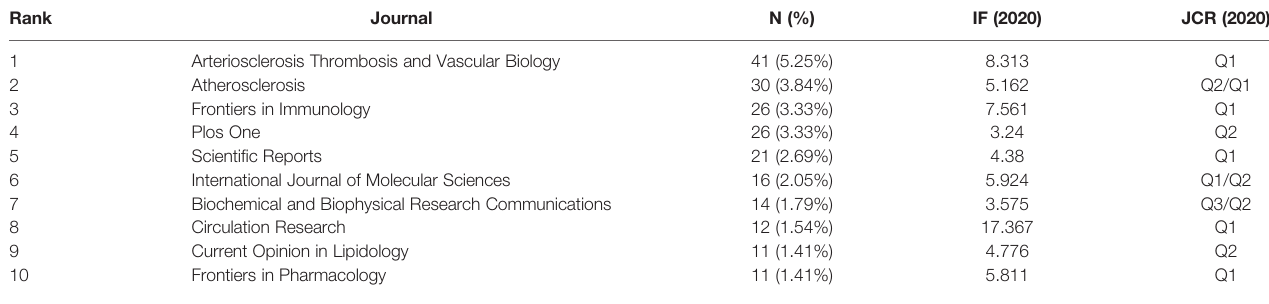
TABLE 3 | The top 10 journals of macrophage polarization in AS